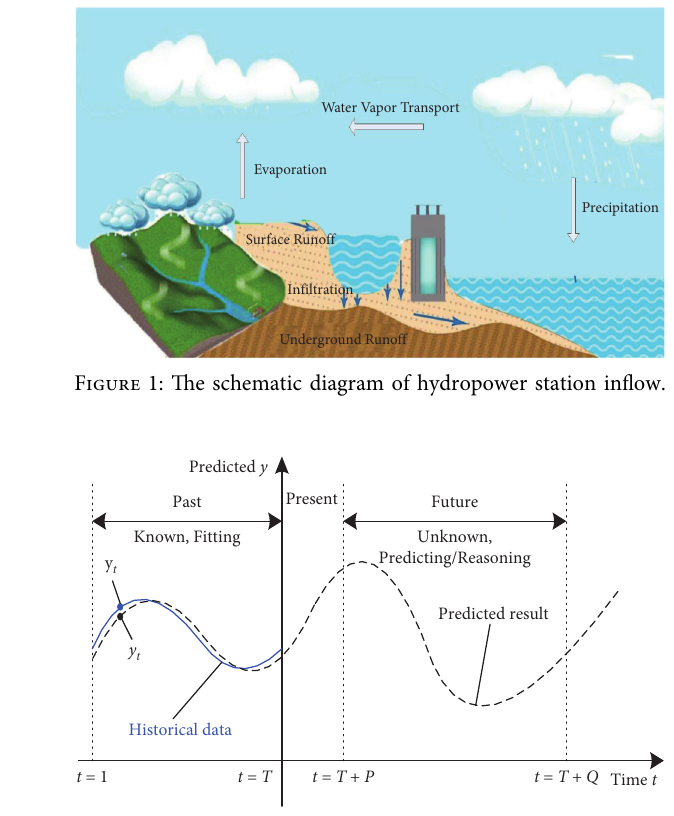
Figure 2: The schematic diagram of the time series prediction